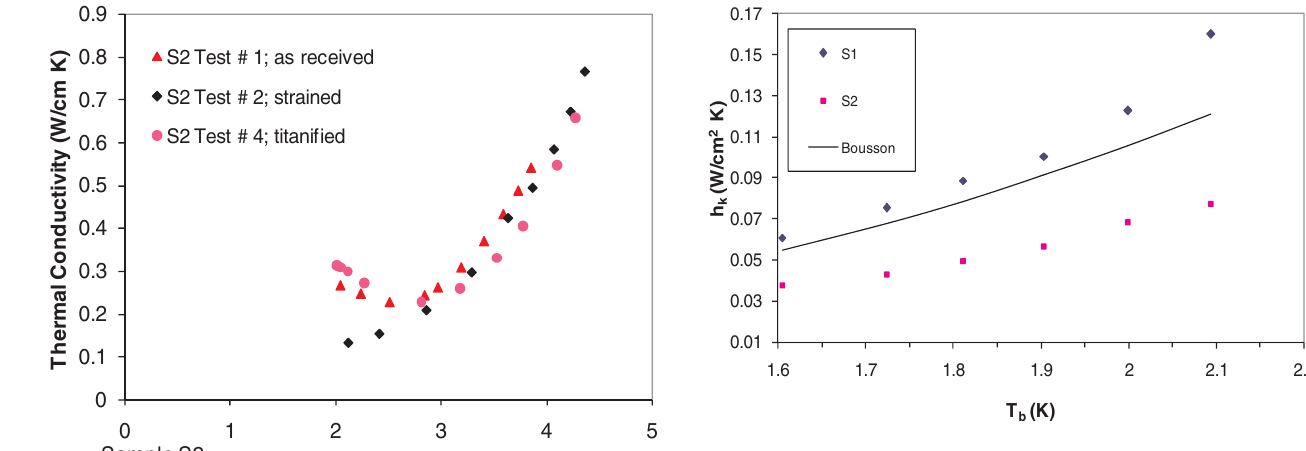
FIG. 12. (Color) Kapitza conductance measurements for the two cylindrical samples, S1 and S2, carried out in test #1, are compared with the one given by Bousson et al. [10].